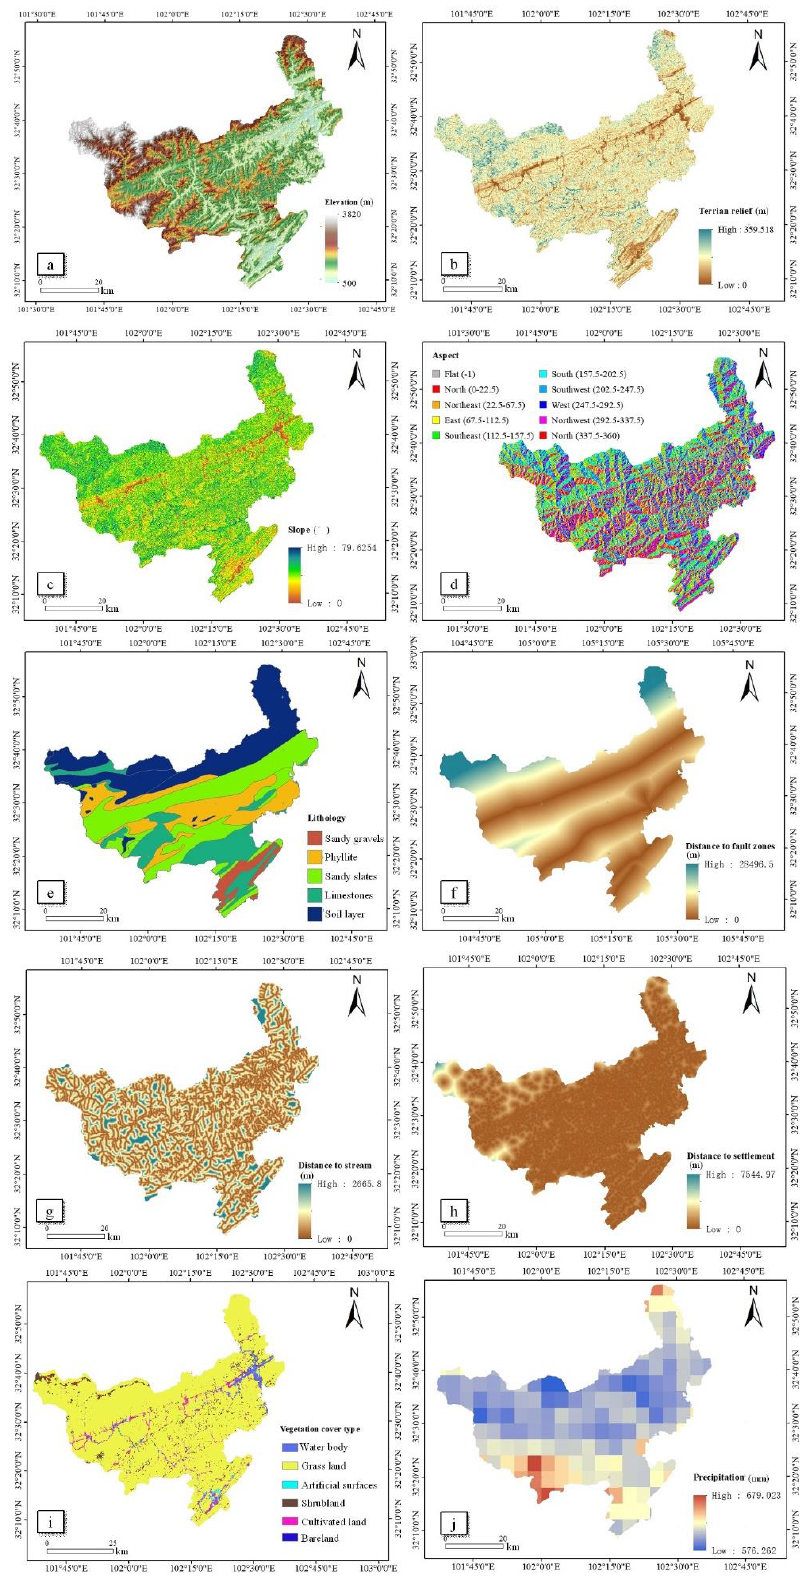
Figure 2. Zoning map of ( a ) elevation, ( b ) terrain relief, ( c ) slope, ( d ) aspect, ( e ) lithology, ( f ) distance to fault zones, ( g ) distance to stream, ( h ) distance to settlement, ( i ) vegetation coverage types, and ( j ) precipitation.